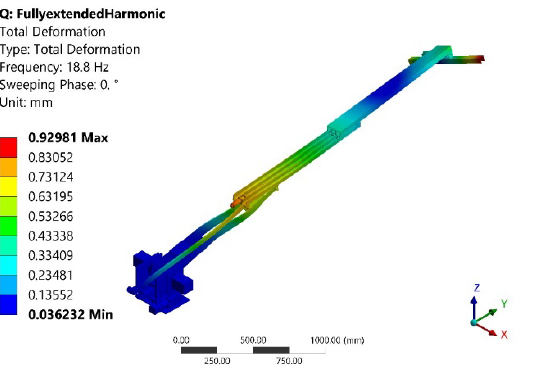
Figure 16. Total deformation (in mm) of the fully-extended configuration structure resulting from the harmonic analysis at the 4th natural frequency (18.8 Hz).